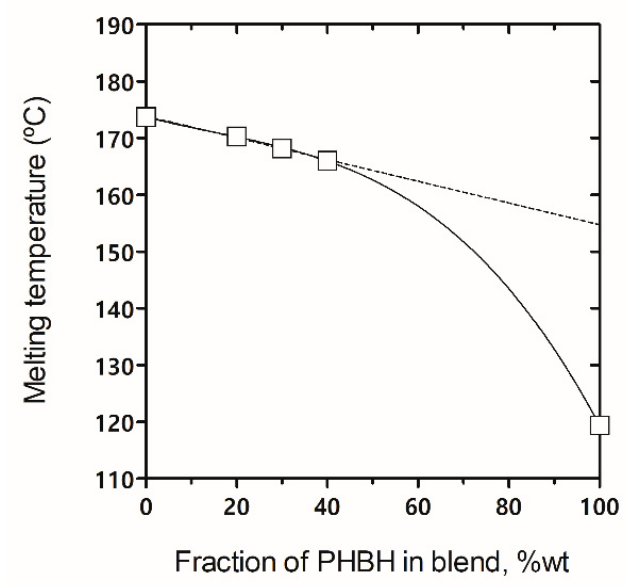
Figure 6. Melting temperature values of the poly(3-hydroxybutyrate- co -3-valerate) (PHBV)/poly(3- hydroxybutyrate- co -3-hydroxyhexanoate) (PHBH) blends depending on the PHBH fraction.